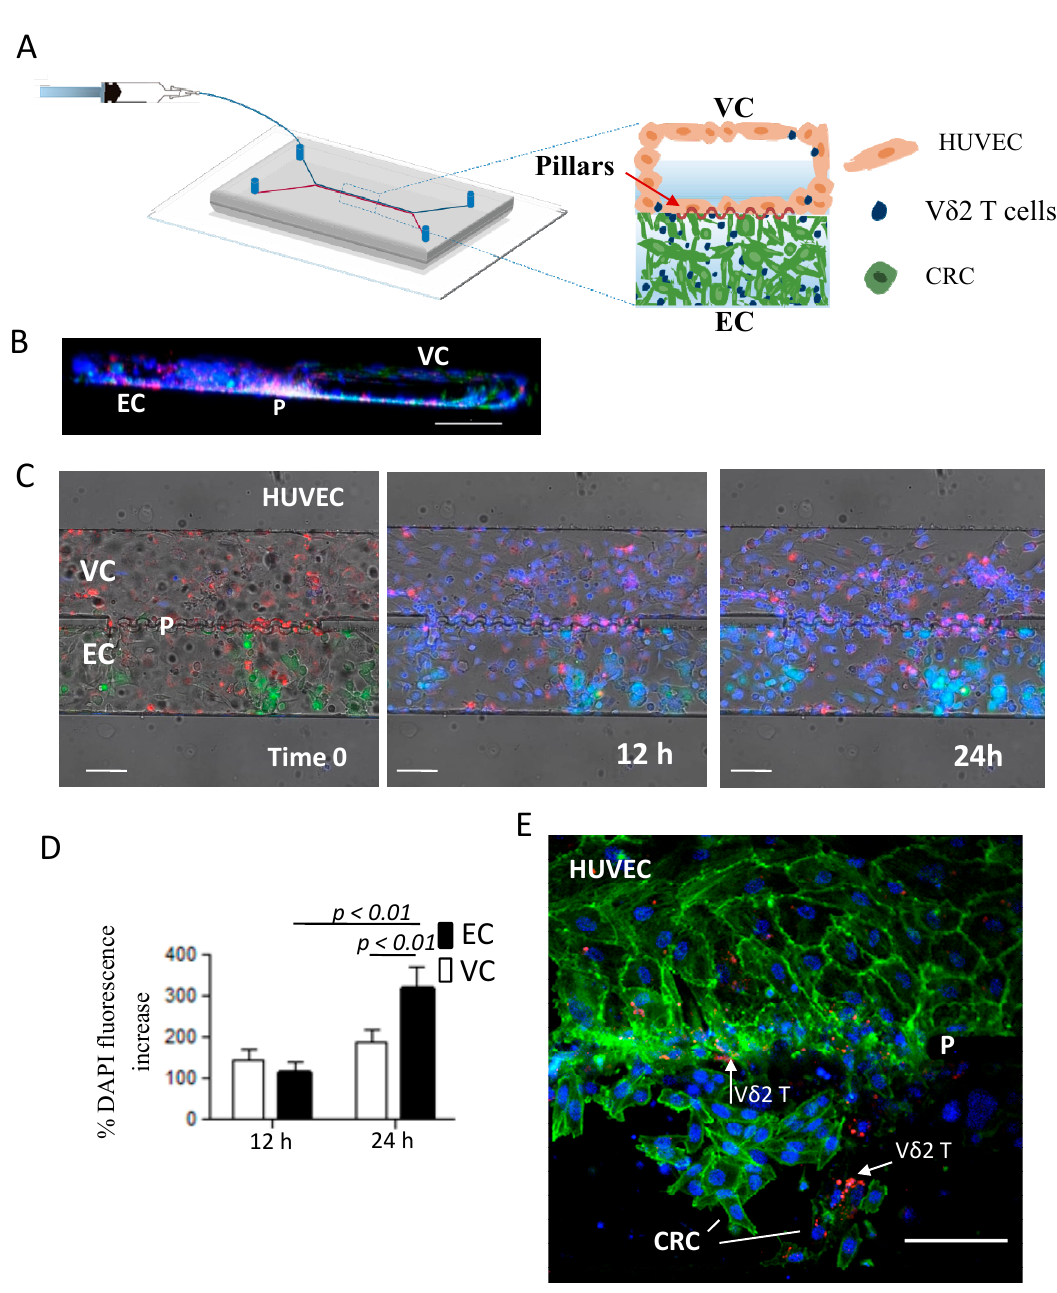
Figure 6. Transendothelial migration of ZA-SPN-expanded V δ 2 T lymphocytes toward CRC cells in a microfluidic system. ( A ) Double-chamber microfluidic chip [50] composed of a vascular compartment (VC), uniformly coated with human umbilical vascular endothelial cells (HUVECs), and an extravascular compartment (EC), hosting a Matrigel matrix with CRC cells. The two compartments were separated by an array of micropillars, equally spaced by 3 µ m. ZA-SPN-expanded V δ 2 T cells were infused through the inlet into the VC, and their extravasation was mainly analyzed around the pillar area. ( B ) 3D reconstruction (lateral view) of the double channel microfluidic chip, showing on the right the HUVECs covering all of the channel (green / blue, phalloidin / DAPI) to mimic a complete vessel (VC); on the left, tumor cells (CRC, nuclear blue staining) in the EC. P: micropillar zone. Some V δ 2 T cells stained with CM-Dil (red) were visible in both compartments. Scale bar: 100 µ m. ( C ) Time-lapse images following the localization of ZA-SPN-activated V δ 2 T lymphocytes before (time 0) and after (12 h, 24 h) injection into the VC. HUVEC membranes were stained using CM-Dil (red) and V δ 2 T cell nuclei were stained by DAPI (blue). EC: extravascular channel populated with GFP + SW480 CRC cells (green). P: micropillars. Scale bar: 100 μ m. ( D ) Quantification (Image J software) of DAPI fluorescence intensity increase measured at 12 h